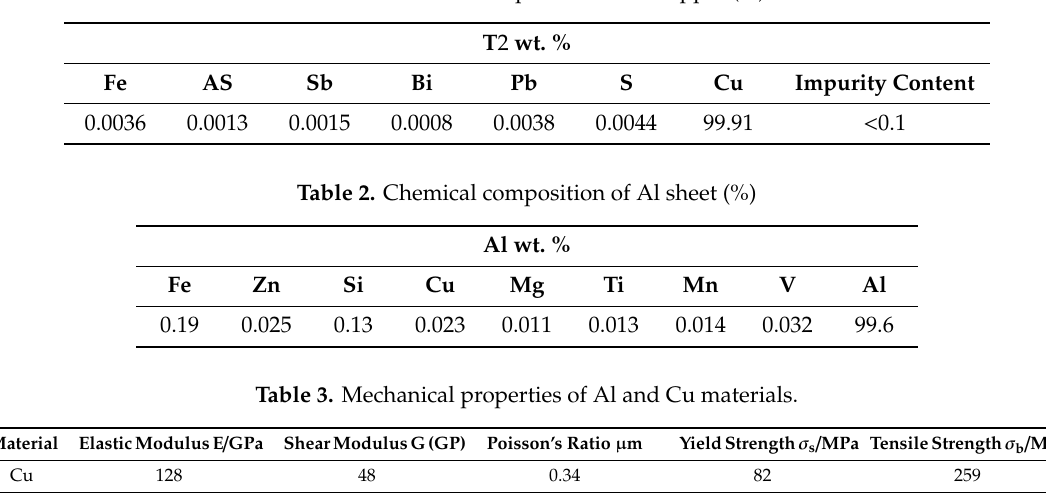
Table 1. Chemical composition of T2 copper (%)